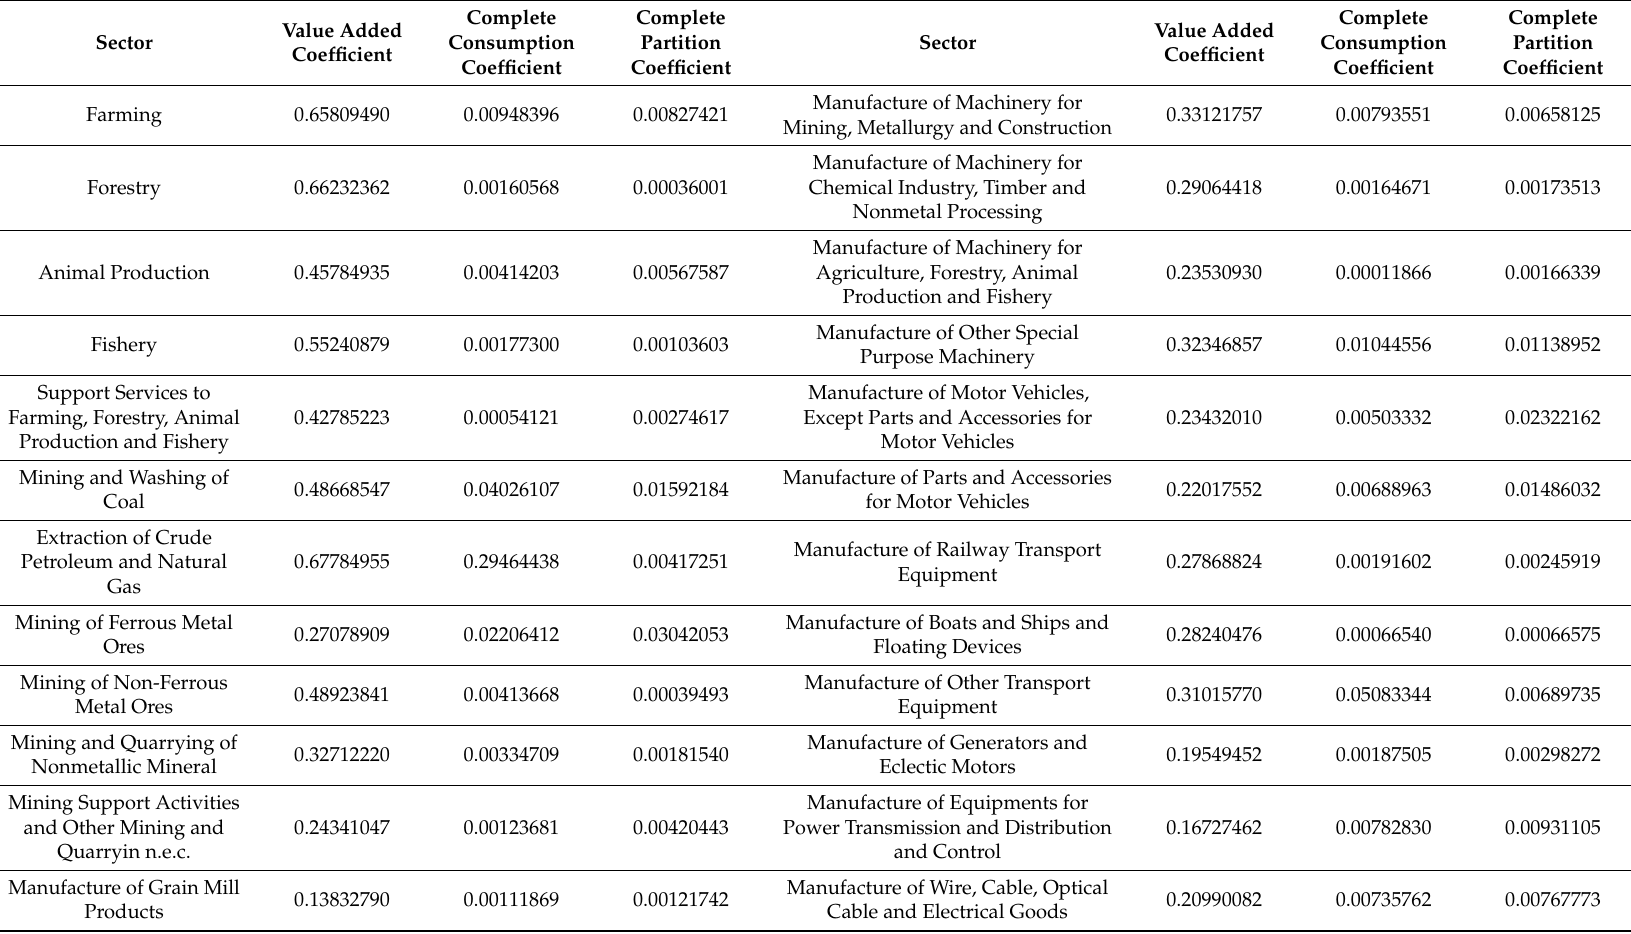
Table A1. Value added coefficient, complete consumption coefficient and complete partition coefficient of 139 sectors of